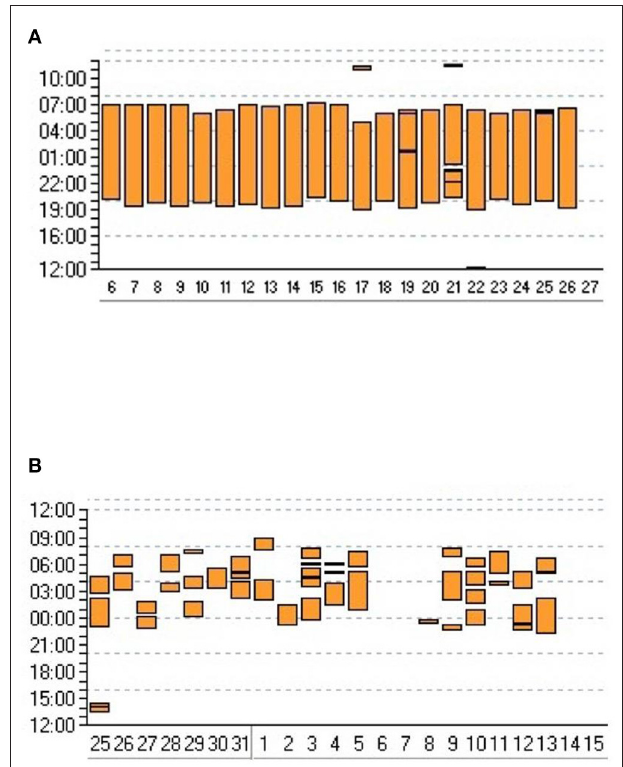
FIGURE 1 | Adherence to NIV. Graphic transcription of ventilator use provided by ventilator software. Y axis: time of the day/night; X axis: days. Each vertical bar represents time spent using the ventilator for a given day. (A) Very regular use suggesting that patient is adherent and comfortable with his/her treatment. (B) Frequent interruptions and irregular use of ventilator suggesting discomfort and/or